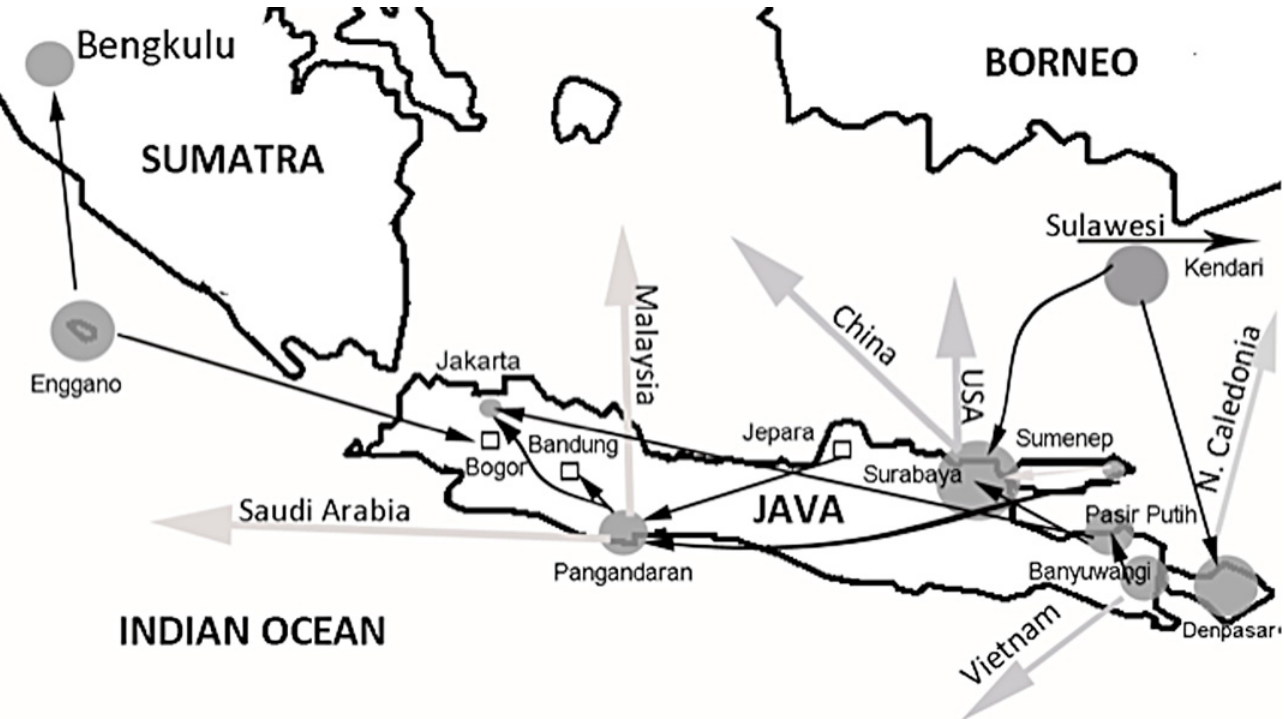
Fig 3. Shell trade networks. Protected marine molluscs shell trade networks in Java and Bali, Indonesia. Size of circles are proportional to the volume of trade: small = 10s, medium-100s, large-1000s and very large = 10,000s. Kendari is situated in south-central Sulawesi 800 km northeast of Bali.